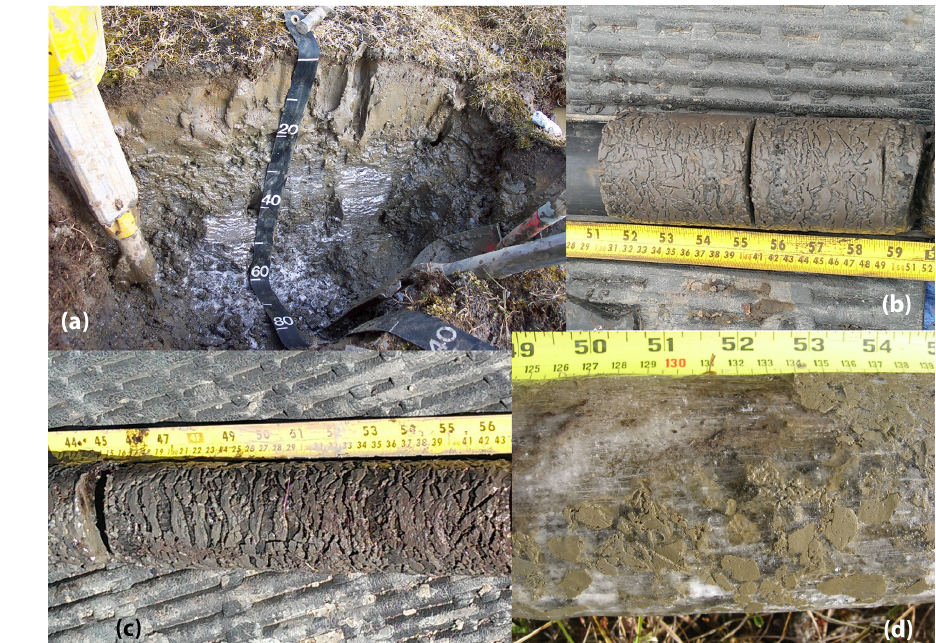
Figure 1. Examples of common cryostructures: (a) lenticular structures visible below 30–40cm in a freshly exposed profile of an earth hummock, Mould Bay, Arctic Canada (reprinted by permission, ASA, CSSA, SSSA); (b) lenticular structures transition to a reticulate structure at 130–150cm in a core extracted from the center of a low-centered ice-wedge polygon; (c) lenticular structure; and (d) suspended (ataxitic)